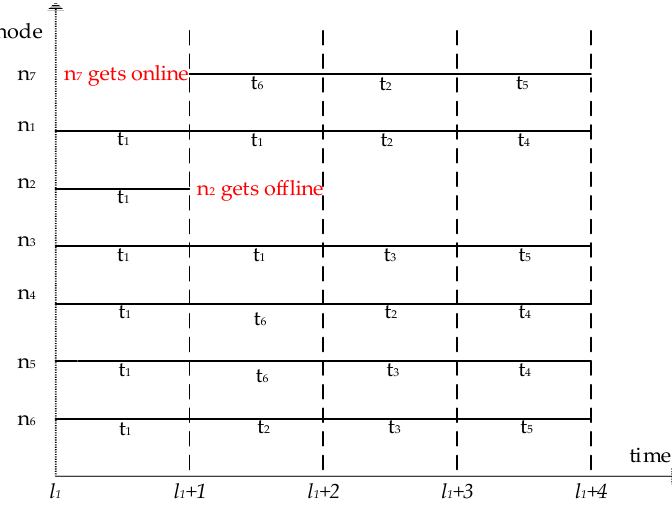
Figure 4. The execution processes of the deadline preference dispatch scheduling (DPDS) algorithm.